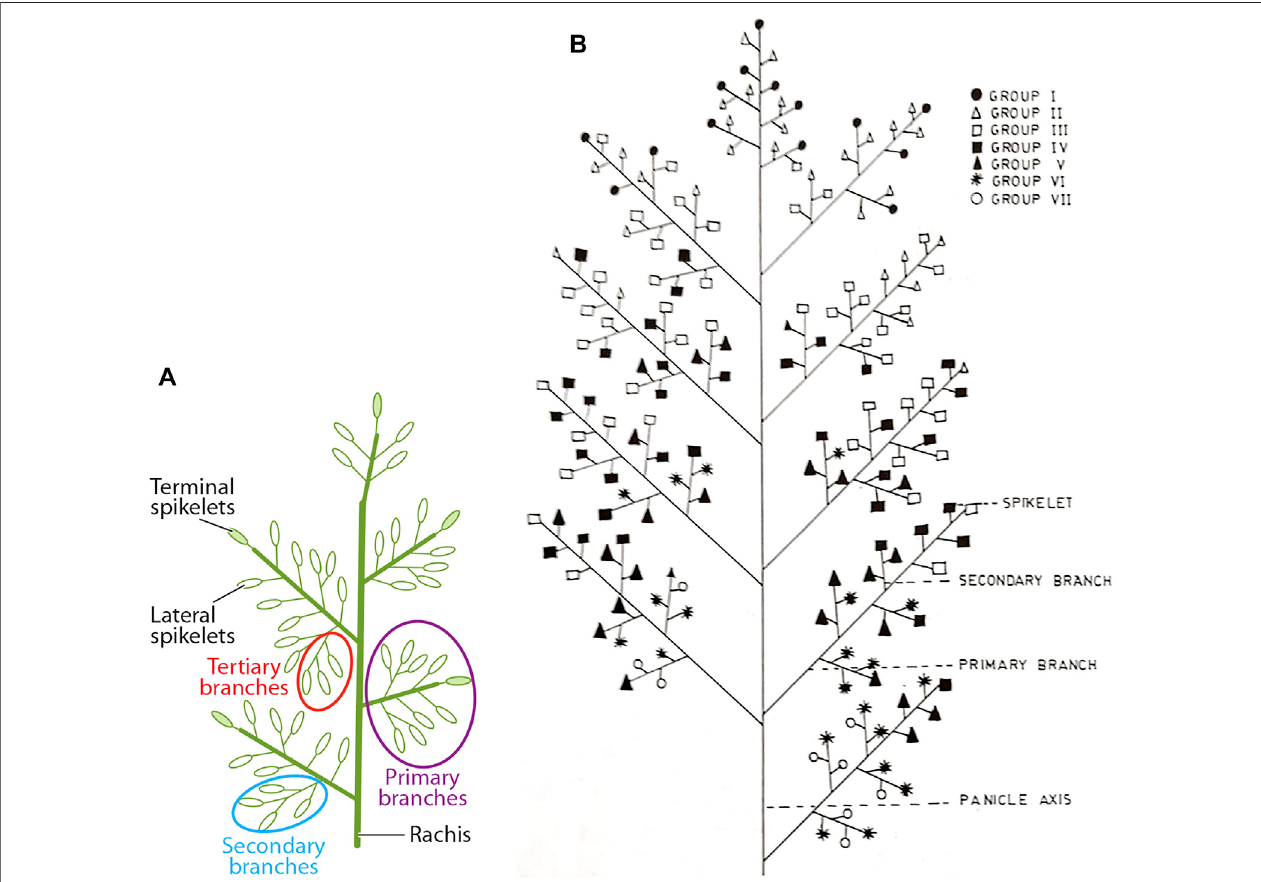
FIGURE 1 | Spatial distribution and development of spikelets on the rachis of the rice panicle . (A) The spikelets are termed as terminal or lateral depending upon whetherthesearederivedfrom themodi fi cation oftheaxis,termedasterminalspikelets,orthelateralbranches,termedaslateralspikelets.Thelateralbranchesmay be primary, secondary, or tertiary in nature depending upon whether these are originated from the rachis, primary branches, or secondary branches, respectively. (B) Pictorial representation of progression of anthesis of the spikelets on the rice panicle, which is an acropetal event with spikelet groups I, II, III, IV, V, VI, and VII reaching anthesis progressively on the fi rst, second, third, fourth, fi fth, sixth, and seventh days (Mohapatra et al., 1993). Groups I to III represent the apical (superior) spikelets, while groups V to VII represent the basal (inferior) spikelets. Panel 2A is reproduced with the permission of the author (Xing and Zhang, 2010). Panel 2B is reproduced with the permission of the publisher (Mohapatra et al.,